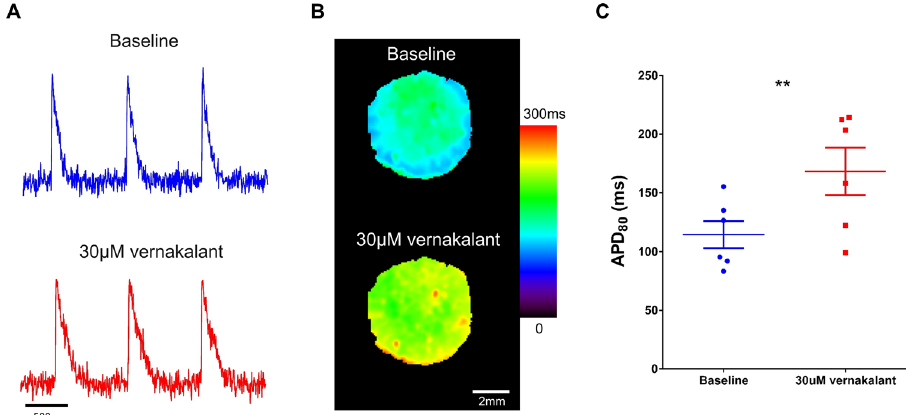
Fig. 1 Effect of vernakalant on APD in hiPSC-derived atrial cell sheets. A Example of optical action potentials acquired from the two-dimensional hiPSC- derived atrial cell sheets at baseline (top) and following treatment with 30 µ M vernakalant (bottom). Notice the atrial-like triangular-shaped optical action potential morphologies and the longer APD after the drug treatment. B APD 80 color-coded maps depicting APD 80 values at each pixel of the atrial cell sheets at baseline (top) and following vernakalant treatment (bottom). C Summary of mean APD 80 values at baseline and upon administration of 30 µ M vernakalant. Note the signi fi cant (** P = 0.0074, two-sided paired t test, n = 6) APD 80 prolongation (from 115 ± 12 to 168 ± 20 ms) following the drug treatment. Source data is provided as a Source data fi